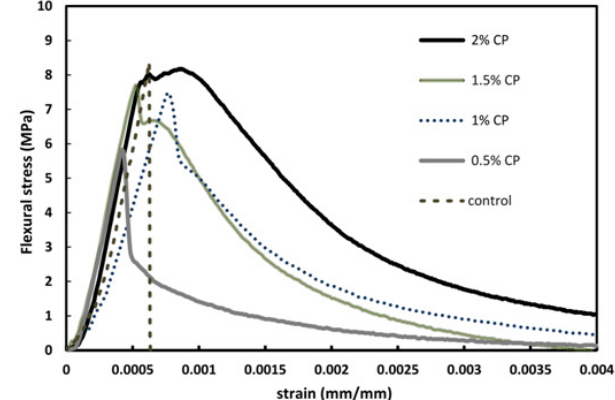
Fig. 4. Stress-strain curve of cement composites containing cellulose pulp